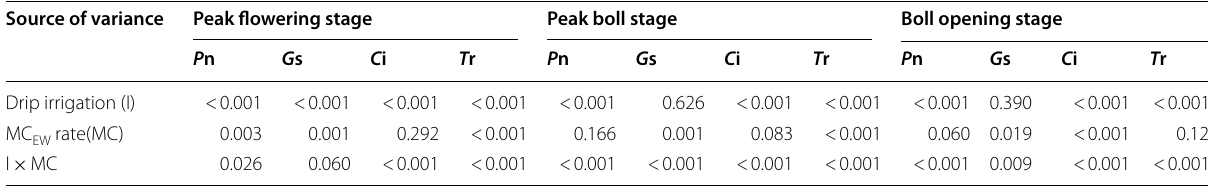
effects and their interactions on gas exchange parameters at EW